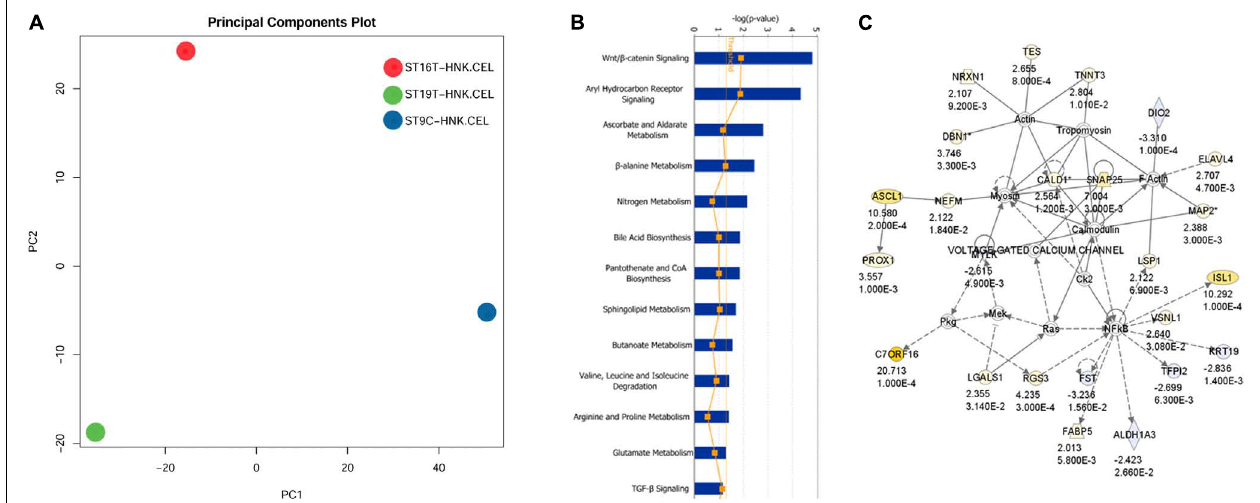
FIGURE 6 | IGE for HH19 compared with HH16 macroarray. (A) Background correction, normalization, expression calculation, and PCA generation were performed by affystart, a package within affycoretools run in R 3.5.2 (R Core Team, 2018; MacDonald, 2018). (B) Focus pathways in HH19 versus HH16 differential expressed genes. (C) The top network in the HH19-HH16 differential expressed